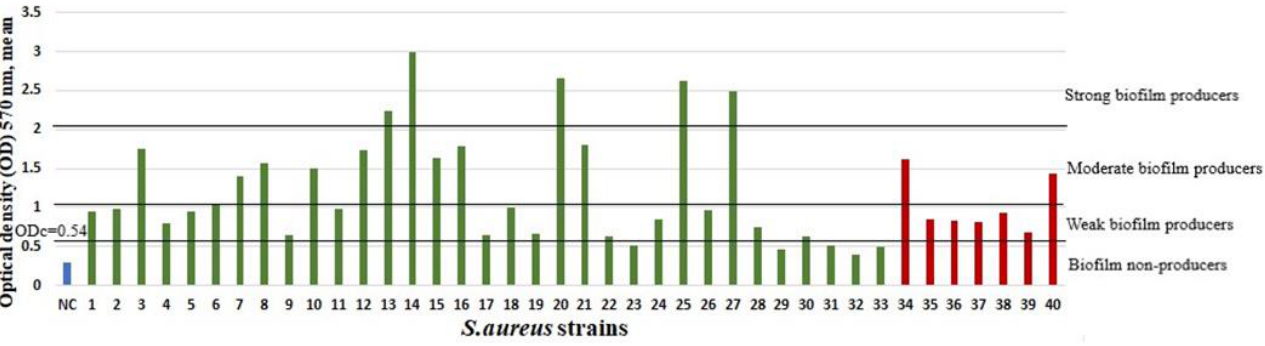
Figure 1. Biofilm-production capability on a microtiter plate of S. aureus strains from patients with RT (1–33 green bars) and patients with a PTA (34–40 red bars). Bars represent mean values of OD (measured at wavelength of 570 nm). Trypticase soy broth with 1% glucose was used as a negative control (NC, blue bar). The cut-off value (ODc) and biofilm-production-capacity levels are marked with horizontal lines.